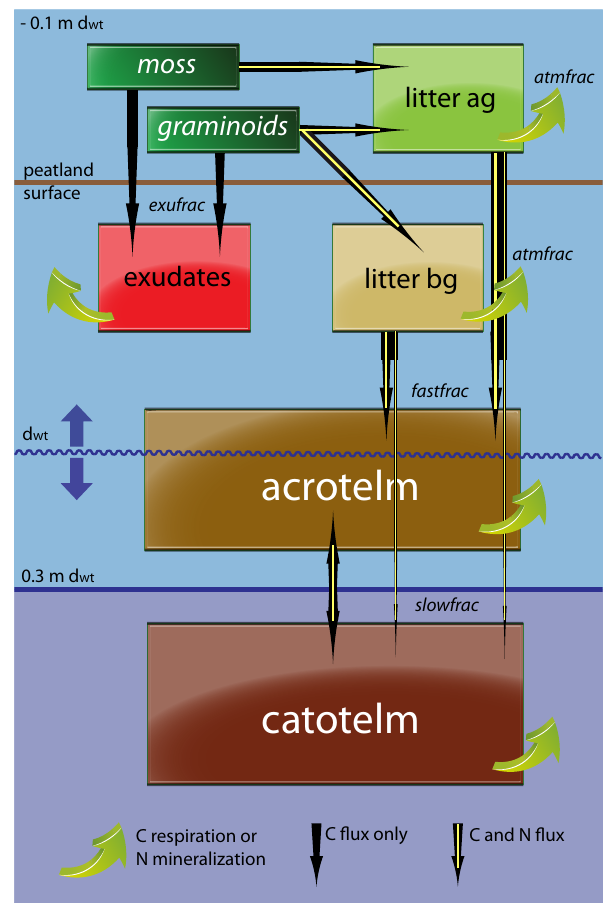
Fig. 1. Scheme of peatland C pools and associated C and N fluxes in LPX. C fluxes originate from NPP or organic matter turnover of both plant functional types: Sphagnum mosses and graminoids. The latter also include all other vascular plants. The water table depth ( d wt ) can vary in the range (light blue area) between the acrotelm depth ( d acro =0.3m) and the maximum of standing water above the surface (0.1m). The catotelm is considered to be always water sat- urated (dark blue area). For the litter pools “ag” and “bg” denote aboveground and belowground,